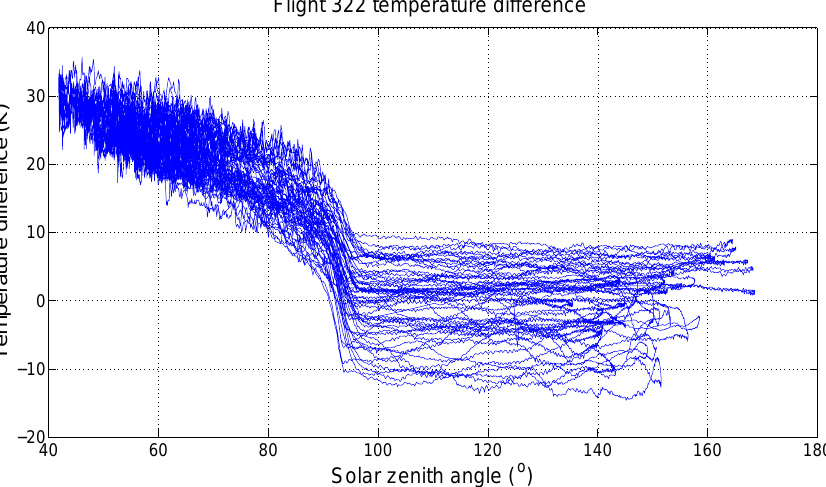
Figure 8. Differences between Loon lift gas and interpolated MERRA-2 temperatures for flight 322. The SZA-dependent bias is clearly visible.